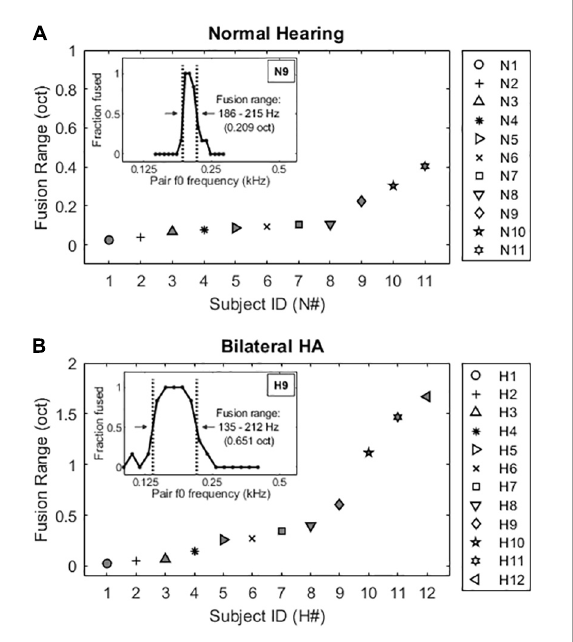
FIGURE4 Individual harmonic tone fusion range results in an octave scale for NH listeners (A) and bilateral HA users (B) . A sample fusion function inset within each panel illustrates the fusion ranges of the 50% points (vertical dotted lines) on the fusion